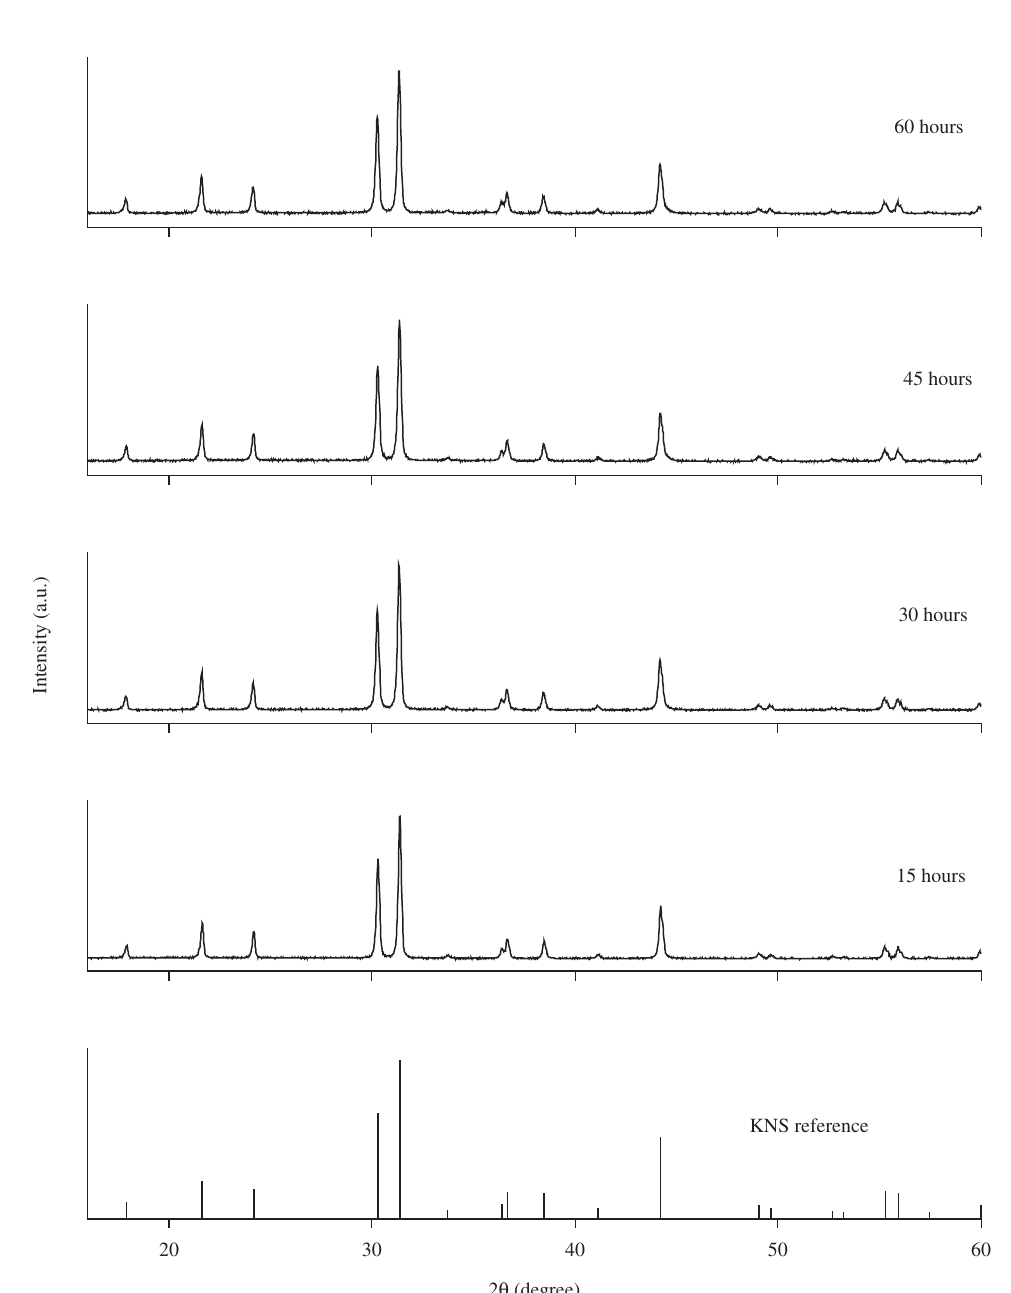
Figure 2. X ray powder diffraction pattern of KNS powder prepared with high milling time (15-60 hours) and the reference pattern of